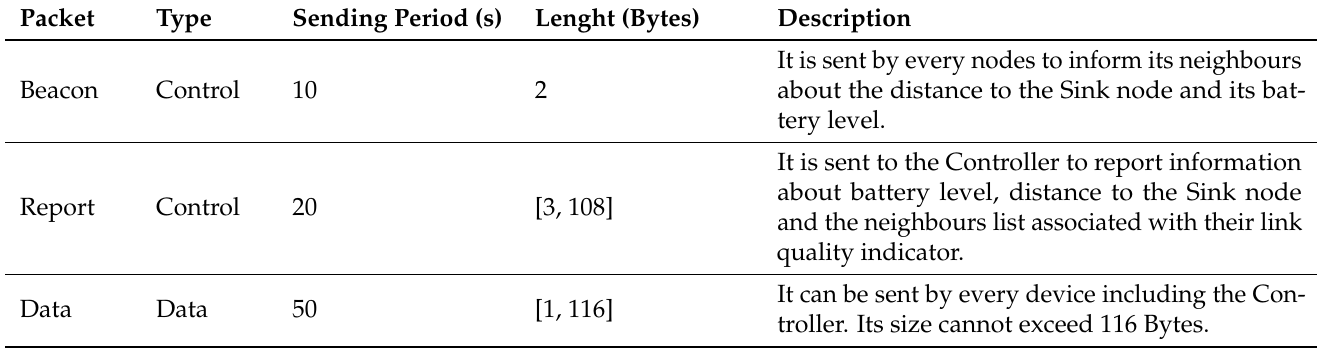
Table 1. Packet features.